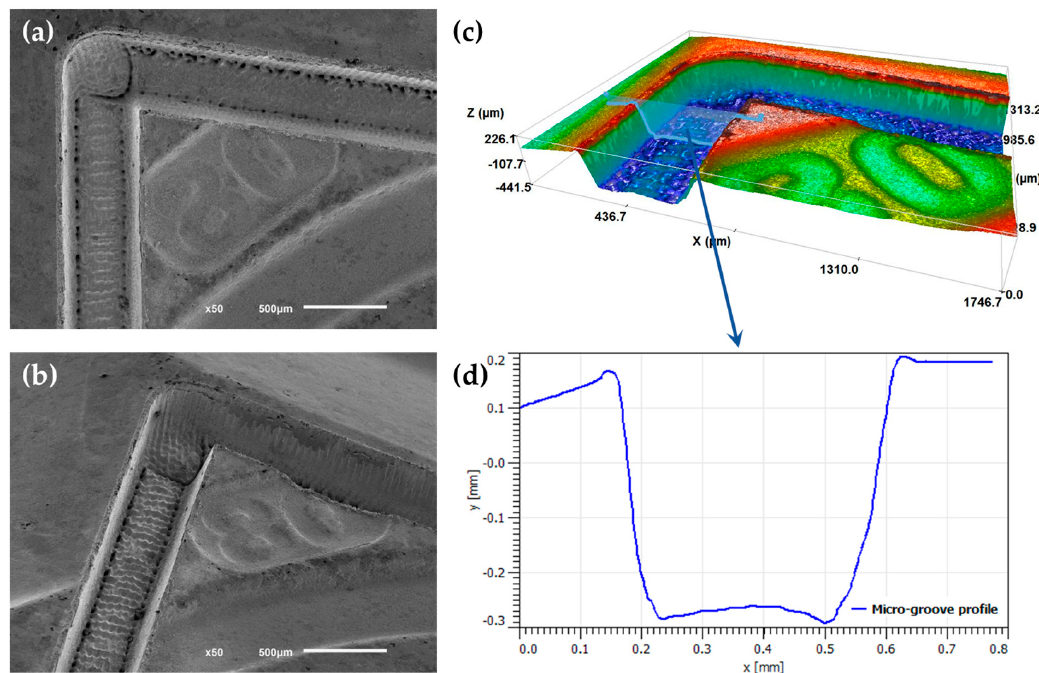
Figure 2. Micro-groove produced by laser surface modification: ( a ) top view SEM image; ( b ) tilt 45° SEM image; ( c ) 3D optical profilometry; and ( d ) surface topography profile.